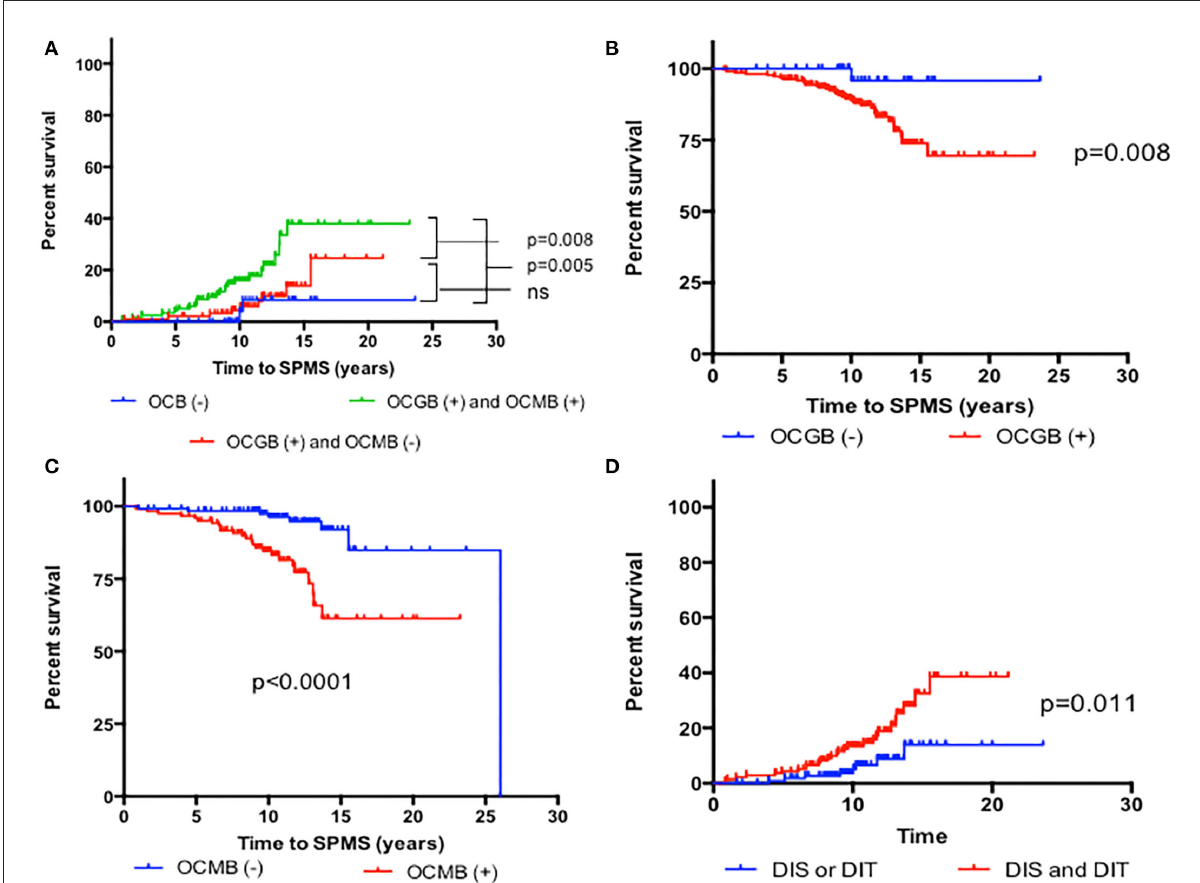
FIGURE4 Kaplan-Meier survival analysis of the time to reach a diagnosis of SPMS according to cerebrospinal fluid characteristics. (A) Presence of both oligoclonal M bands (OCMB) and oligoclonal G bands (OCGB) vs. presence of only OCGB vs. absence of OCMB and OCGB. (B) Presence vs. absence of OCGB. (C) Presence vs. absence of OCMB. (D) Presence of dissemination in space (DIS) or time (DIT) alone, vs. presence or both according to 2017 McDonald at